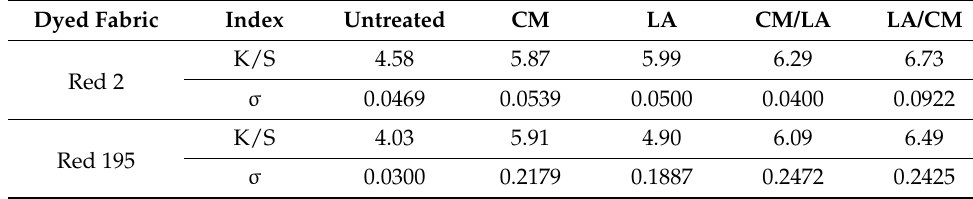
Table 3. K/S and color uniformity values.